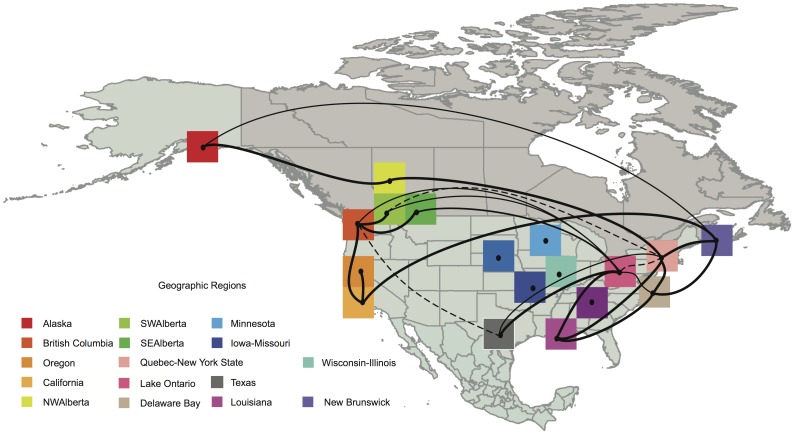
Patterns of viral migration jointly estimated across the 5 internal protein gene segments.Lines connecting discrete regions indicate statistically supported ancestral state changes and are thickened according to statistical support. There are five categories of support. The thinnest lines indicate 6≤BF<10 (supported); 10≤BF<30 (strong support); 30≤BF<100 (very strong support) and the thickest lines with BF≤100 (decisive support). Dashed lines indicate statistical supports between 3≤BF<6 but with posterior probabilities <0.5.